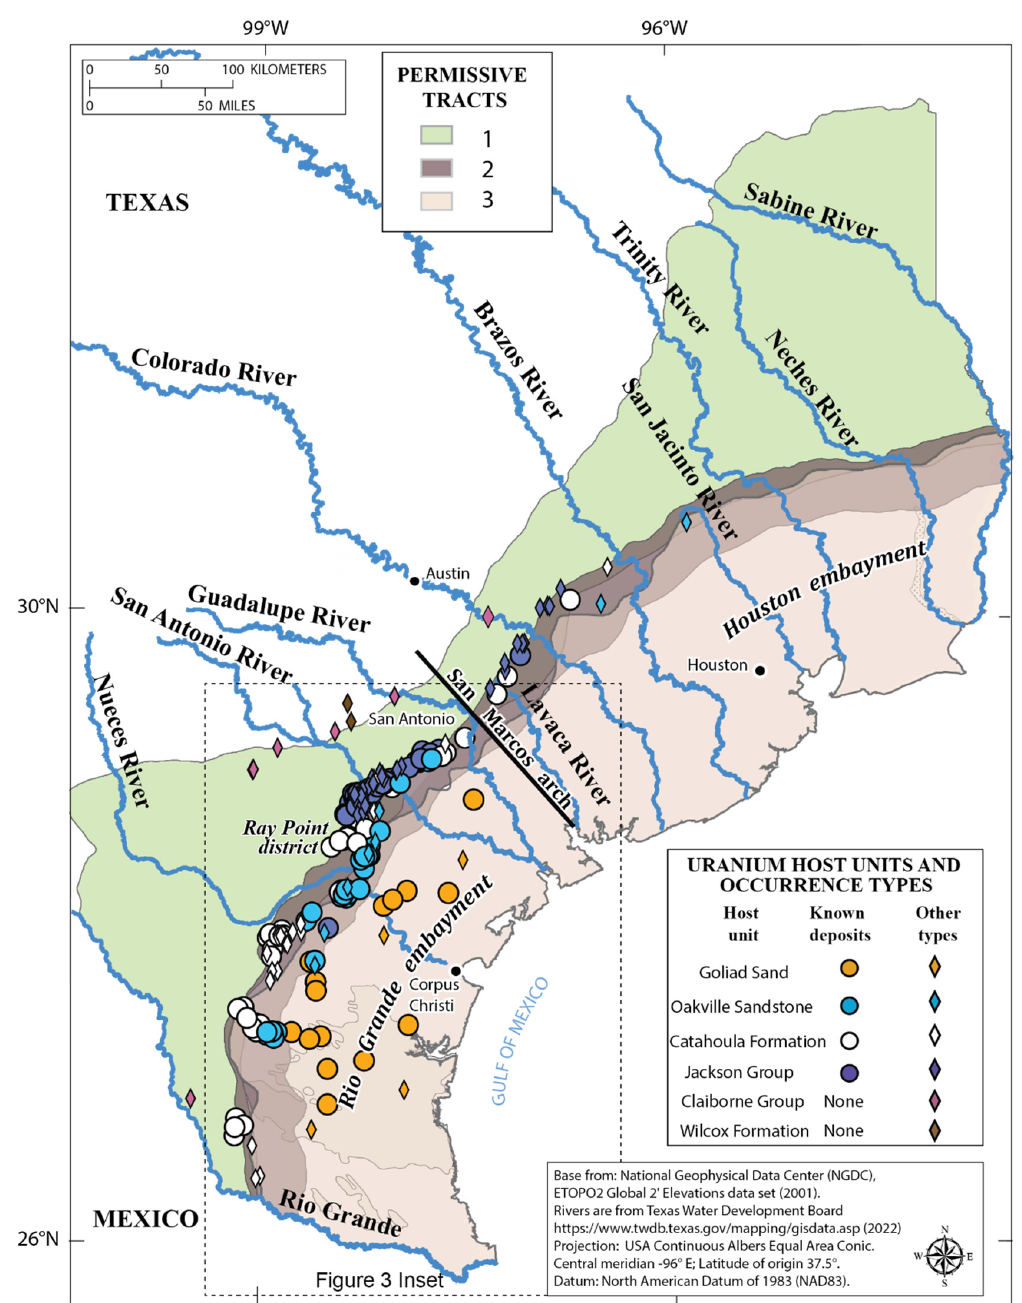
Figure 1. Location map showing the South Texas uranium region; uranium deposits and other types (prospects, showings, and anomalies) of occurrences with host geologic units at those locations; the Houston and Rio Grande embayments; the San Marcos arch; three permissive tracts of the U.S. Geological Survey’s recent assessment of undiscovered uranium resources in South Texas [13]; and location of Figure 3 inset. Modified from [16]. Geology from [19]. The geologic and climatic factors combined in this region to create favorable condi- tions for the development of mineable concentrations of U hosted by Eocene through Pliocene sandstones [16]. Briefly, roll-front deposits are formed by the precipitation of reduced U minerals that occurs when U-enriched, oxidized groundwater encounters re- ducing components in sandstone aquifers. Reductants include in-situ organic matter and